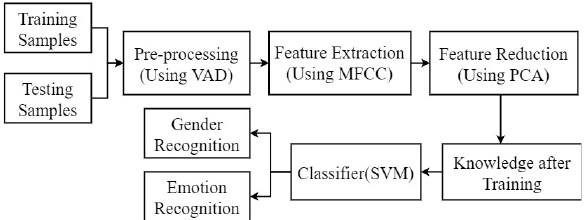
Figure 1. Proposed Model